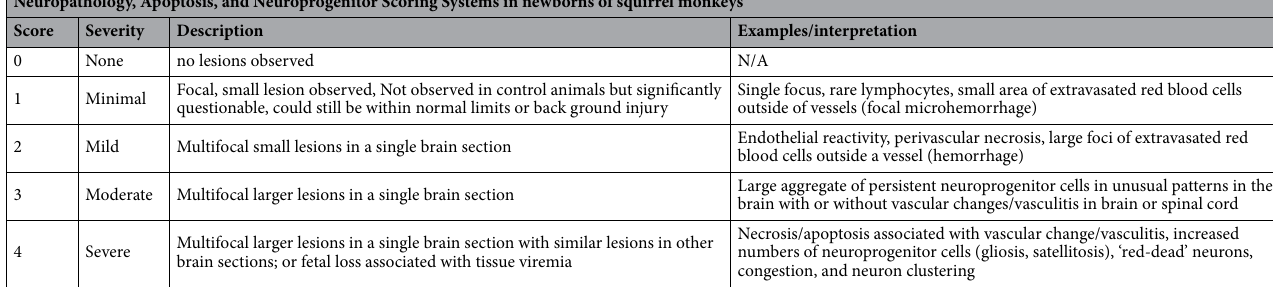
Table 1. Semiquantitative scoring system for histopathological lesions of the newborns SNC used throughout the